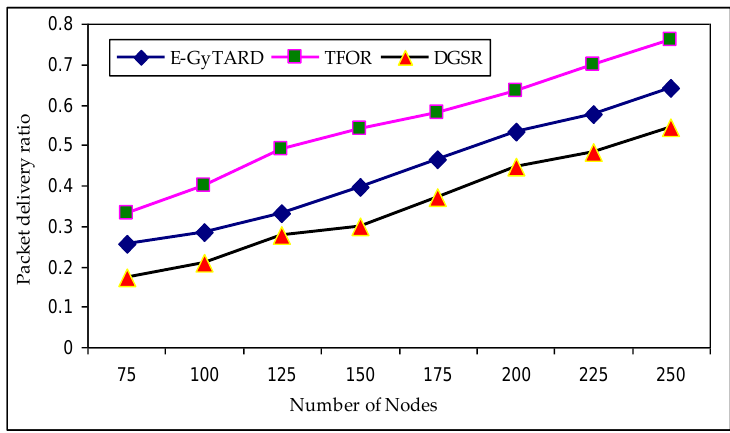
Figure 10. Packet delivery ratio vs. the number of nodes (@5 packets/s).